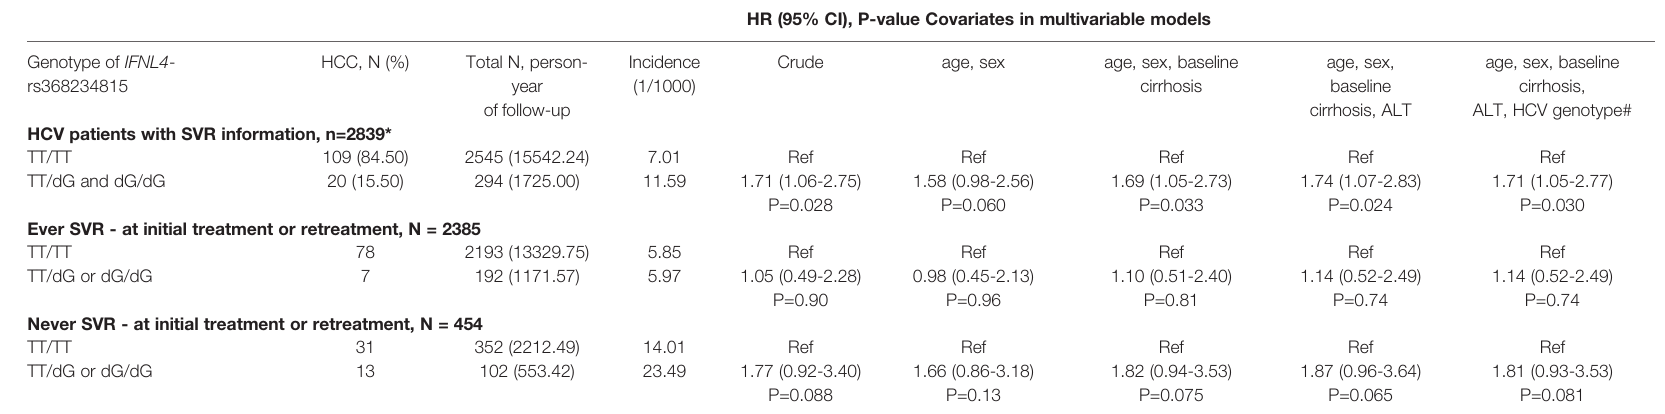
HR (95% CI), P-value Covariates in multivariable models